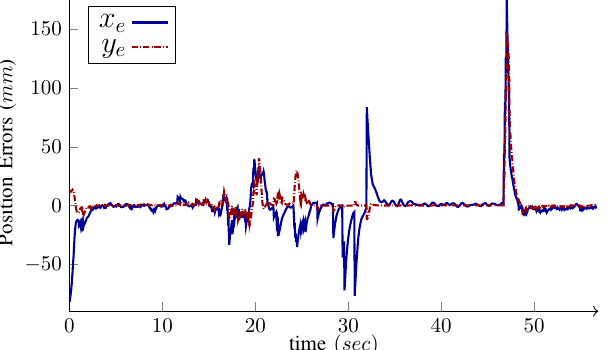
Figure 14. Experiment : Position errors in x and y directions of the inertial frame for the scenario depicted in Figure 13. It shows the disturbances due to the robot moving on a ramp and the localization jump due accumulated error of wheels’ dead